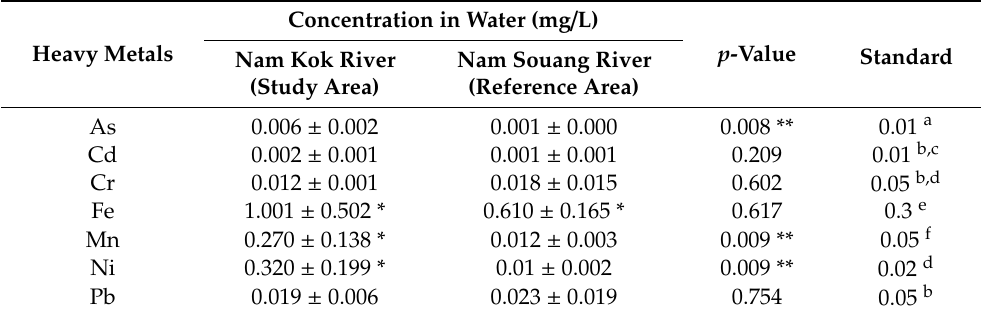
Table 3. Heavy metal and metalloid concentrations in water samples (n = 10) of the Nam Kok river near the Sepon gold-copper mine as the study area and the Nam Souang river as the reference area. Concentration in Water (mg / L)